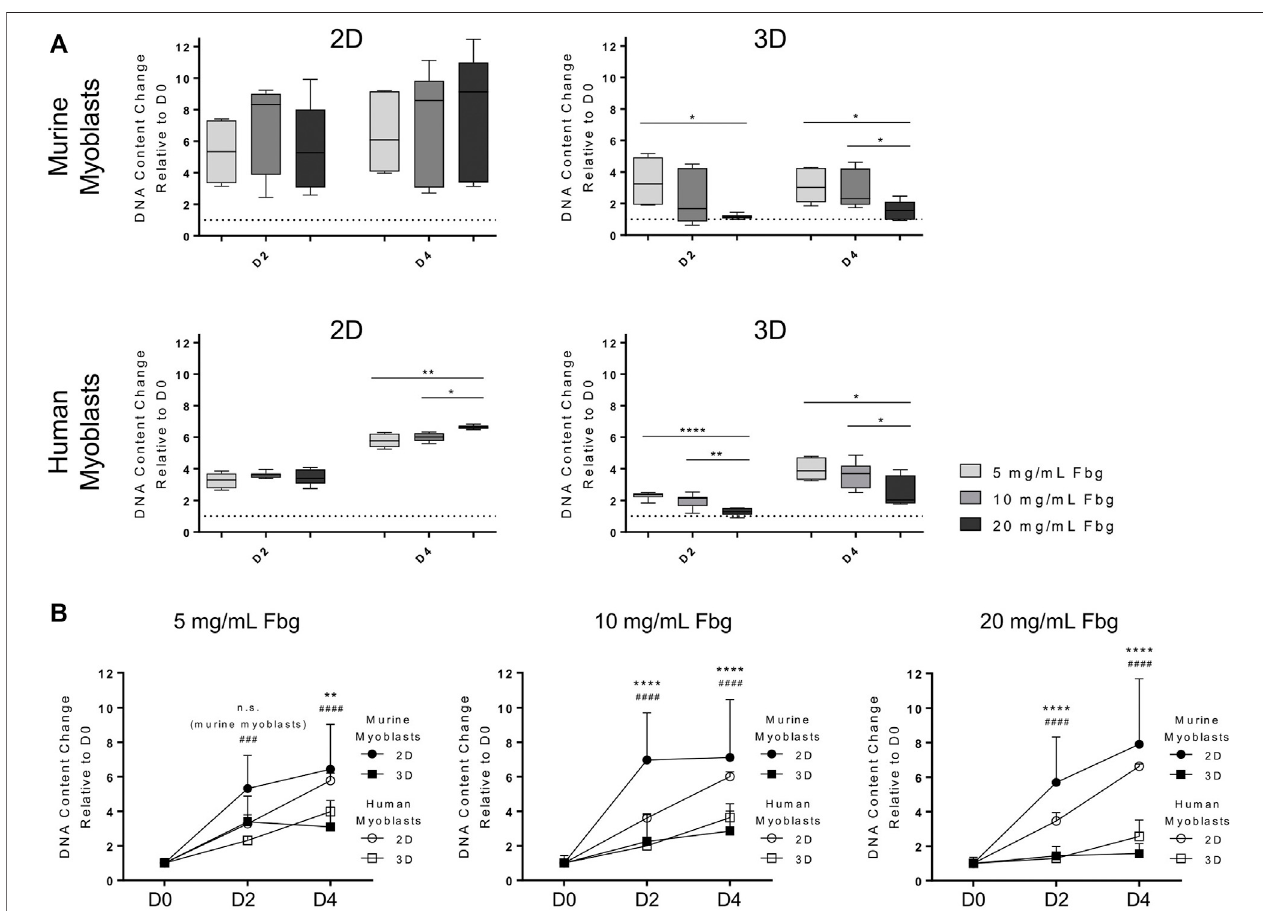
FIGURE 4 | Culture in a 3D setup affects impact of substrate stiffness and myogenic outcome. Murine and human myoblasts were differentiated on fi brin-coated cell culture plates (2D) or encapsulated in fi brin hydrogels (3D) with different stiffness (apparent tensile modulus of 8, 12 and 20 kPa) for 5 days. mRNA expression of markergenesforterminaldifferentiation( troponinTI ( TnntI ), myosinheavychainI ( MHCI )and myosinheavychainII ( MHCII )wasassessedbyRT-qPCR. (A) Foldchange expression levels on day 5 (D5) were normalized to the 8 kPa group for each condition. Data is shown as box and whiskers (min to max); N = 3, n ≥ 8; one-way ANOVAwithTukey ’ smultiple comparison test wasperformedcomparing all rigidities for each condition(2Dand 3D) witheach other,* p < 0.05, ** p < 0.01,*** p < 0.001, **** p < 0.0001. (B) Fold change expression levels were normalized to D0 control samples of each cell line and relative expression over time is shown as a linear curve between means of fold-change values; N = 3, n ≥ 7 two-way ANOVA with Sidak ’ s multiple comparison test was performed comparing all rigidities (8, 12 and 20 kPa) of the two (culture set ups (2D vs 3D) with each other; no signi fi cant difference (n.s.), * p < 0.05, ** p < 0.01, **** p < 0.0001.